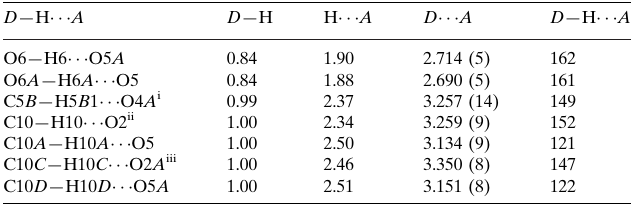
Hydrogen-bond geometry (A˚ , (cid:2)